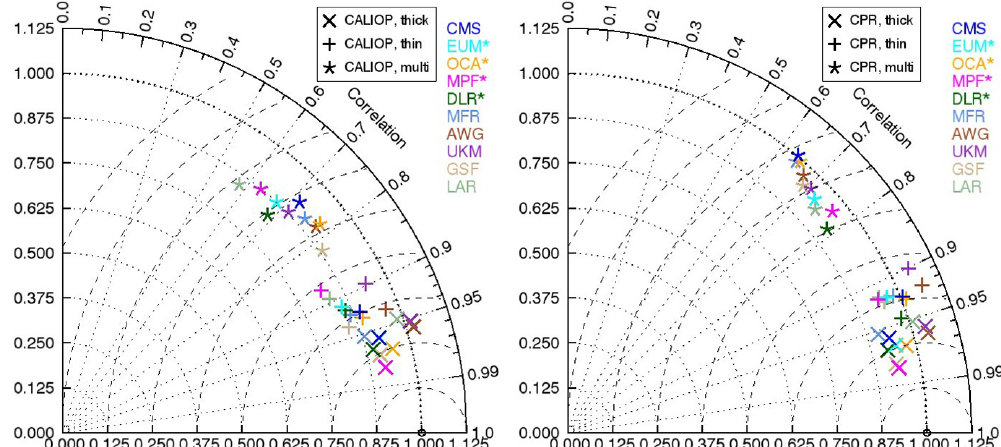
Figure 11. Taylor diagram for CALIOP (left) and CPR (right). Similar to Fig. 9, but the statistics are calculated separately for optically thick ( τ cal ≥ 3) and thin ( τ cal < 3) single layer clouds as well as for multi-layer clouds.